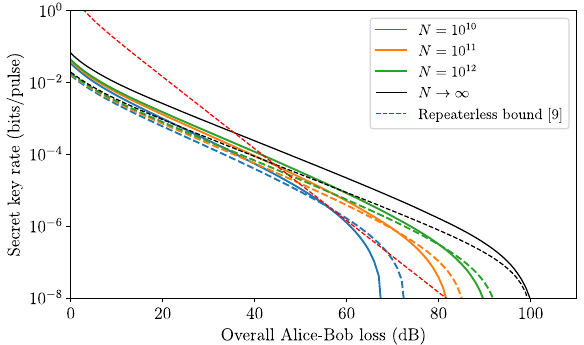
Fig. 4 Comparison between this work (solid) and sending-or-not- sending TF-QKD 30,41 (dashed). We consider different values for the block size N of transmitted signals. All other simulation parameters are stated in the main text.